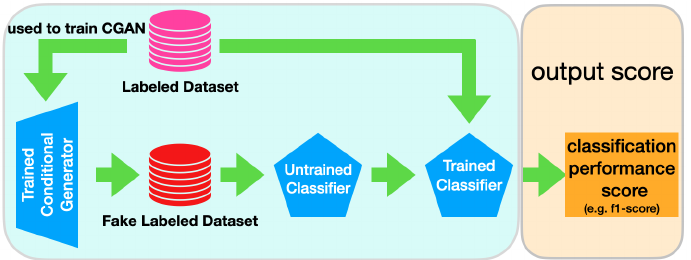
Figure 1. The architecture of an oracle instance based on CAS-real score.